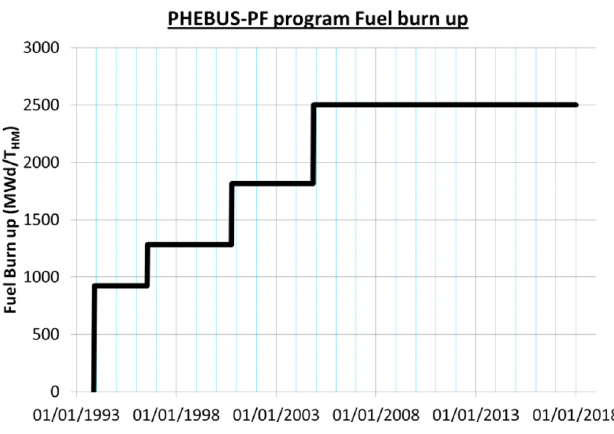
Fig. 4. PHEBUS (cid:1) FP program fuel burn